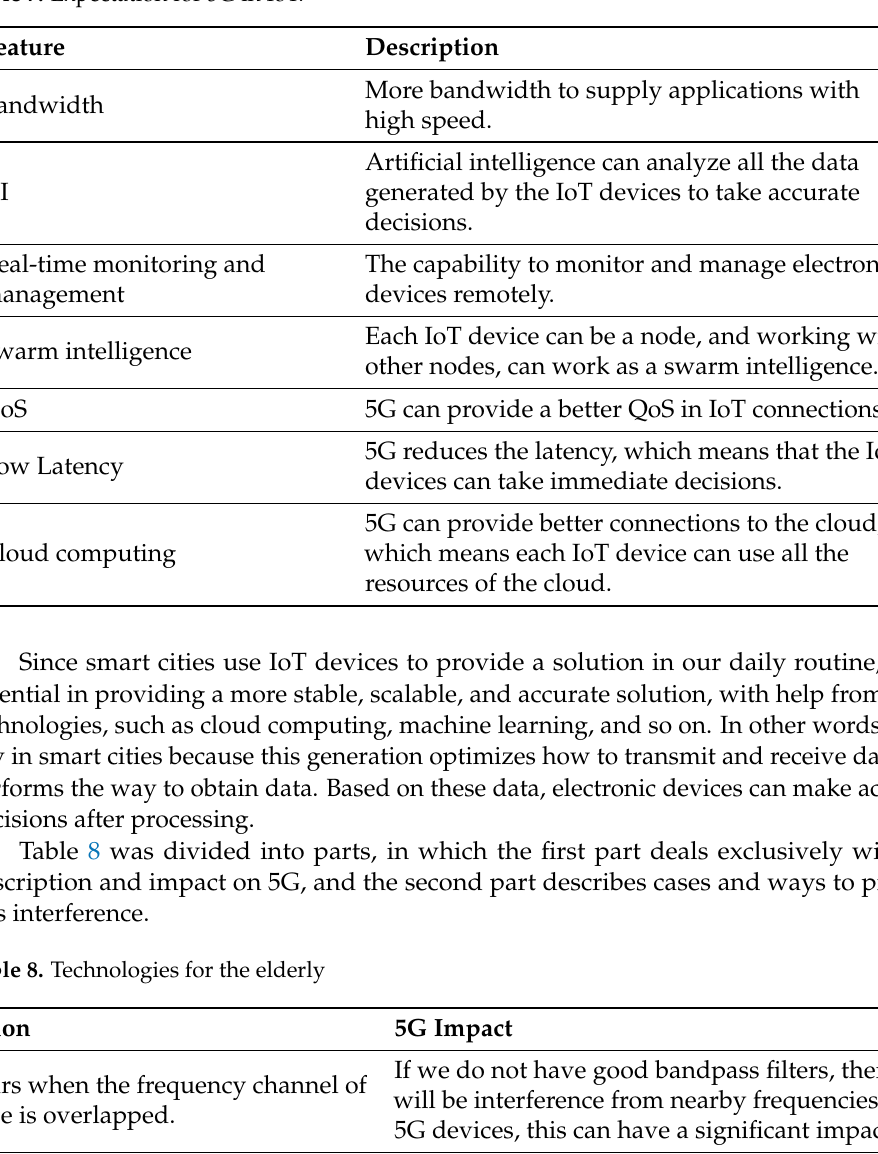
Table 7. Expectation for 5G in IoT.